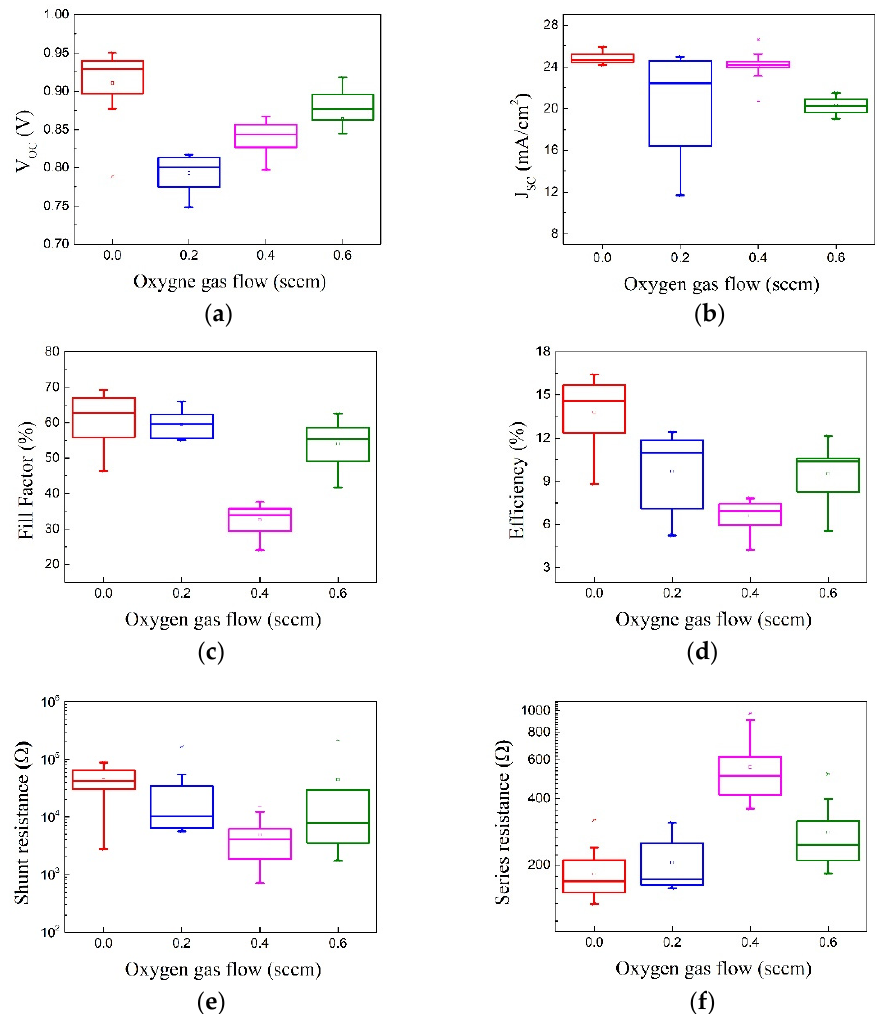
Figure 5. Comparison of PV properties for prepared PSCs with ITO films as a function of oxygen-gas